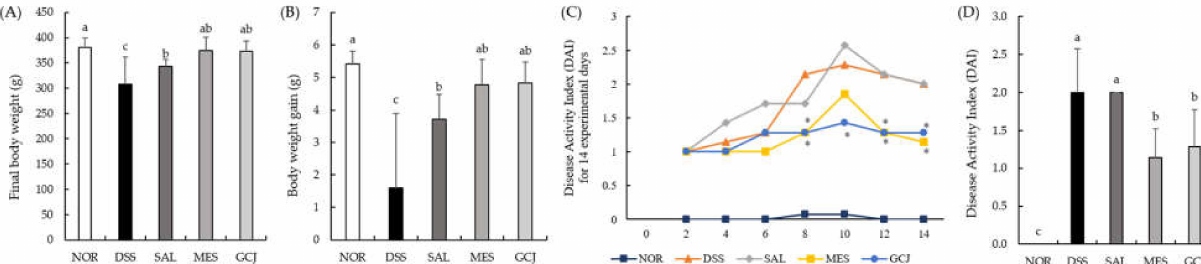
Figure 1. Effects of Gochujang on colitis symptoms in DSS-treated rats. ( A ) Final body weight; ( B ) weight gain; ( C ) DAI scores calculated with time (* p < 0.05 vs. DSS group); ( D ) DAI scores among the groups at day 14. Data are expressed as the mean ± SD ( n = 7 per group). Values with different superscripts (a, b, c) are significantly different among groups according to ANOVA with Duncan’s multiple range test at p < 0.05. NOR—normal group; DSS—DSS group; SAL—SALT group; MES—mesalamine; GCJ— Gochujang